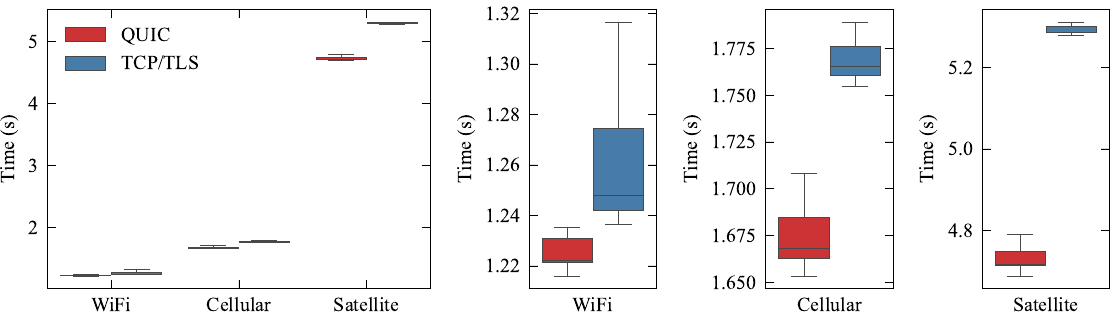
Figure 8. 0-RTT approach with three nodes: publisher; broker; subscriber. The left box plot depicts completion times for the emulated technologies. The other box plots provide enlarged views of the first